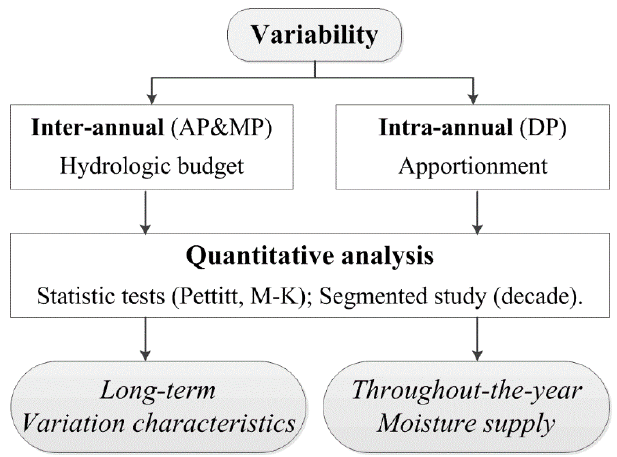
Figure 1. Flow Chart. AP, MP and DP stand for annual, monthly and daily precipitation, respectively.